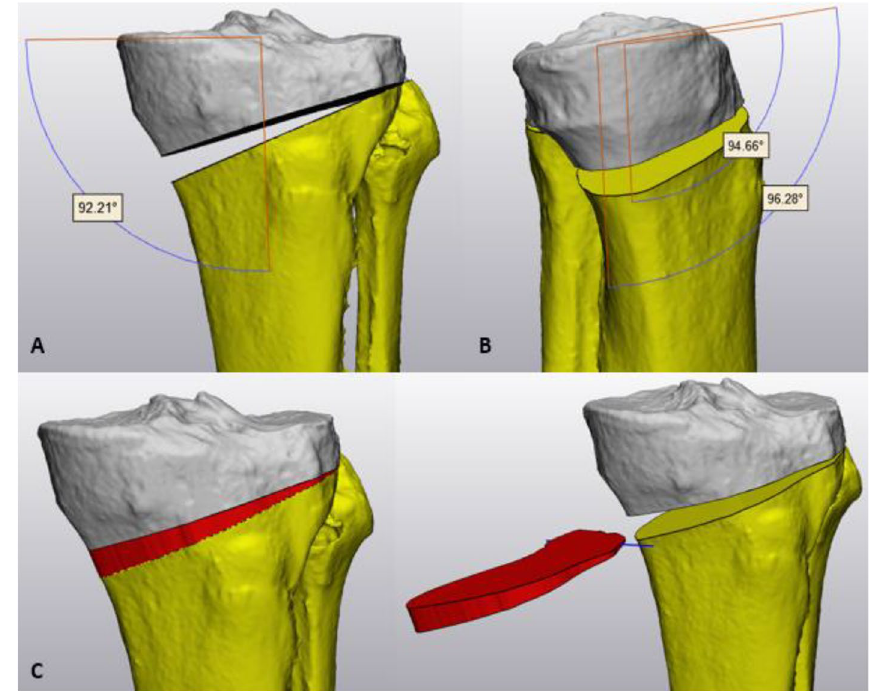
Fig. 1 3D preoperative osteotomy simulation using ( A ) the planning angles MPTA in the coronal plane and ( B ) the tibial slopes in the sagittal plane. ( C ) The negative of the planned osteotomy gap (red) is embodied and exported with the hinge axis (blue) to design the 3D printed customization kit for bone graft